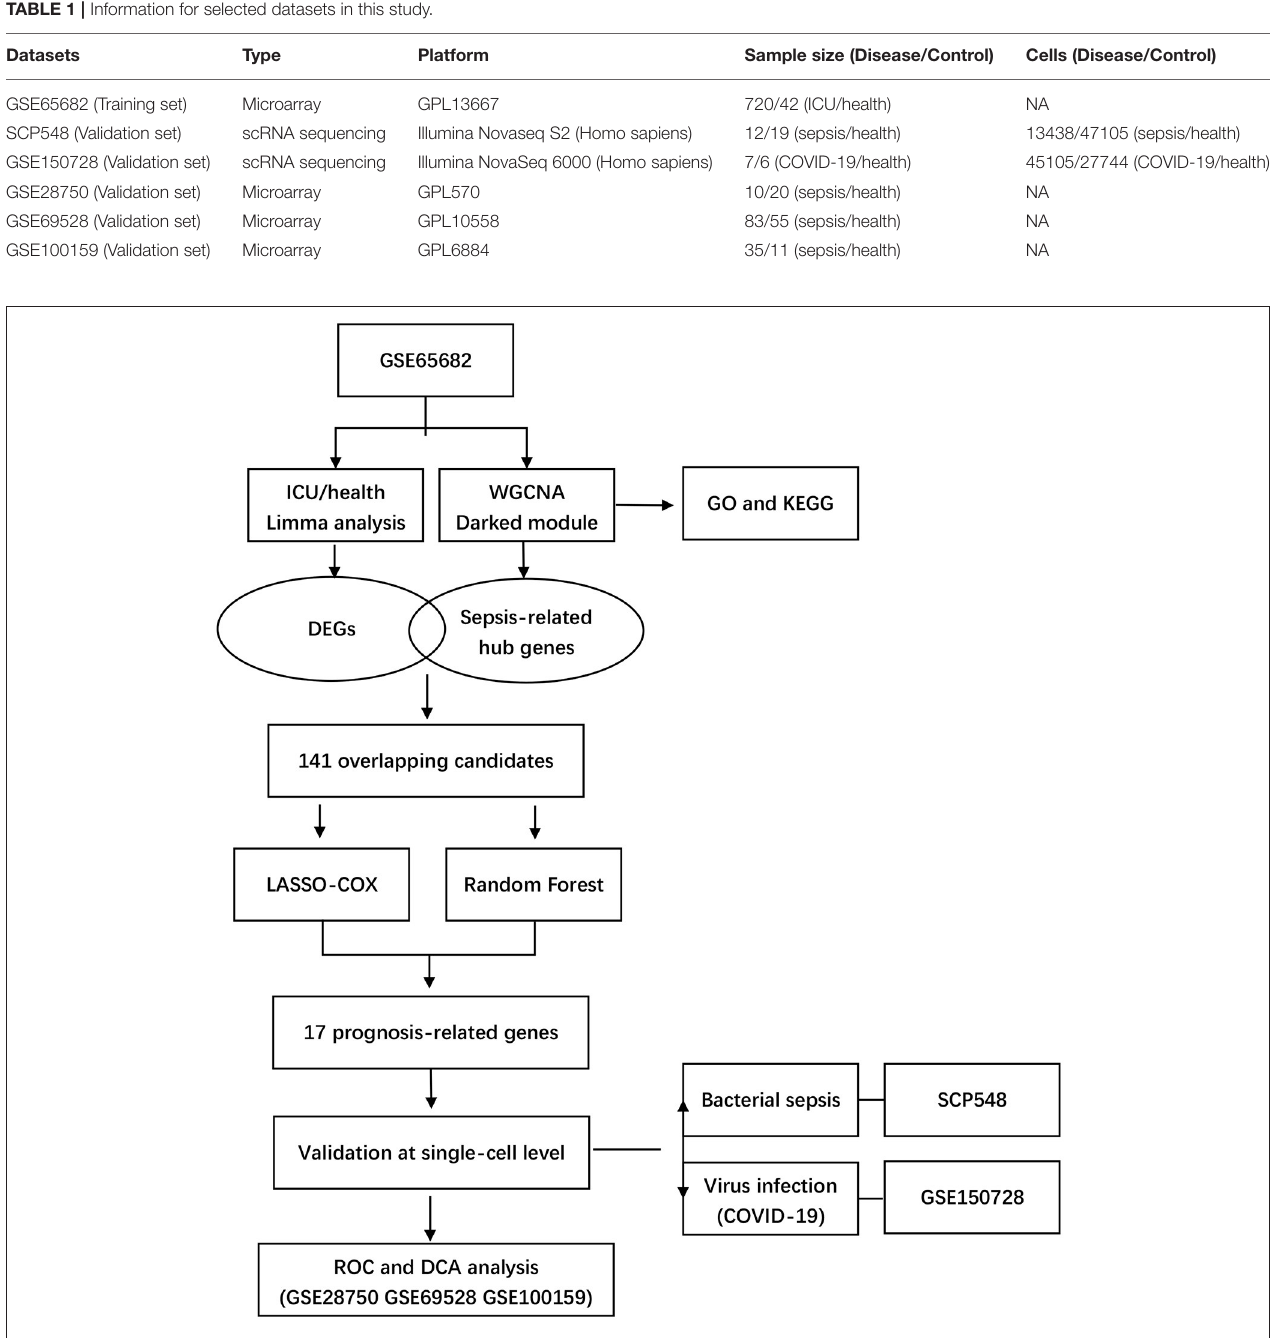
FIGURE 1 | Flowchart of